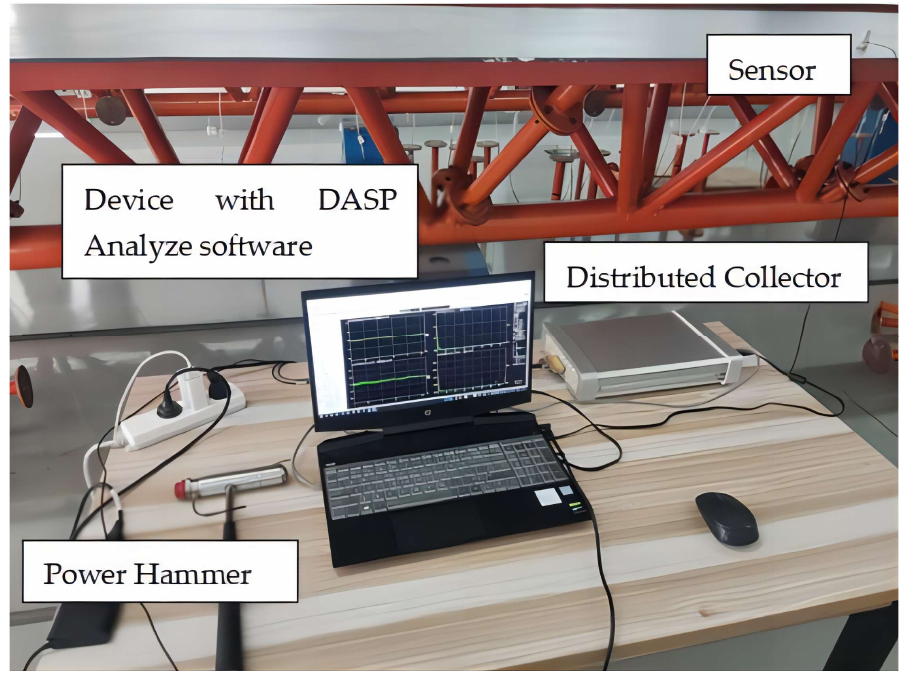
Figure 9. Modal test system of the STTGB deck. Table 7. Main characteristics of the equipment for the modal test of the STTGB deck.